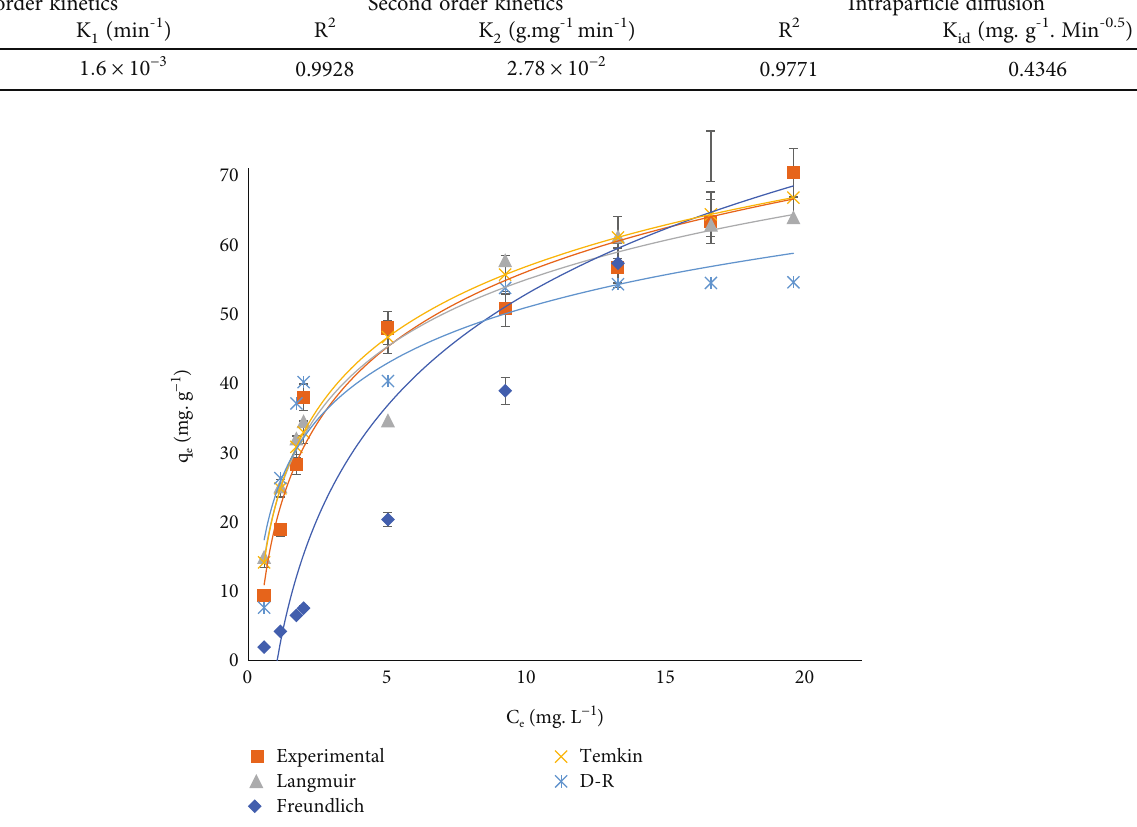
Figure 11: Langmuir, Freundlich, Temkin, and D-R isotherms of PA adsorption onto ACO. Table 3: Isotherms model